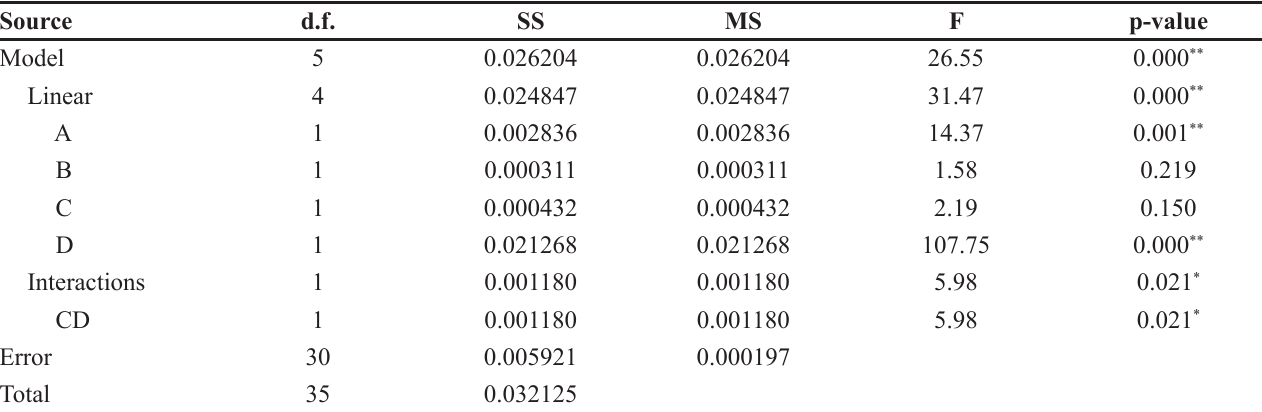
Legend: d.f.: degrees of freedom, SS: Sum of Squares, MS: Mean of Squares, F: calculated F statistics, and p-value: *